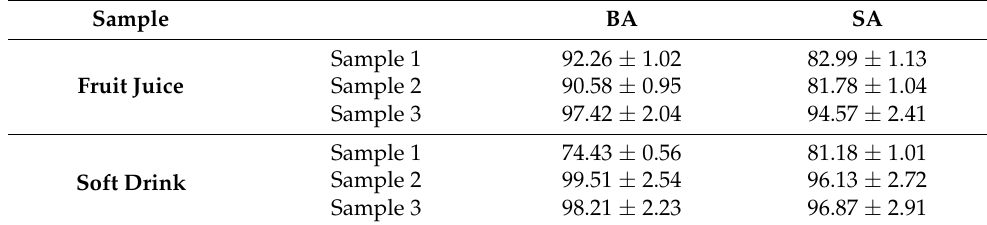
Figure 12. Chromatograms of the soft drink sample ( c ) and the soft drink sample spiked with 5 µg mL −1 of BA and SA ( d ). Benzoic acid: 7.5 min; sorbic acid: 8.4 min.